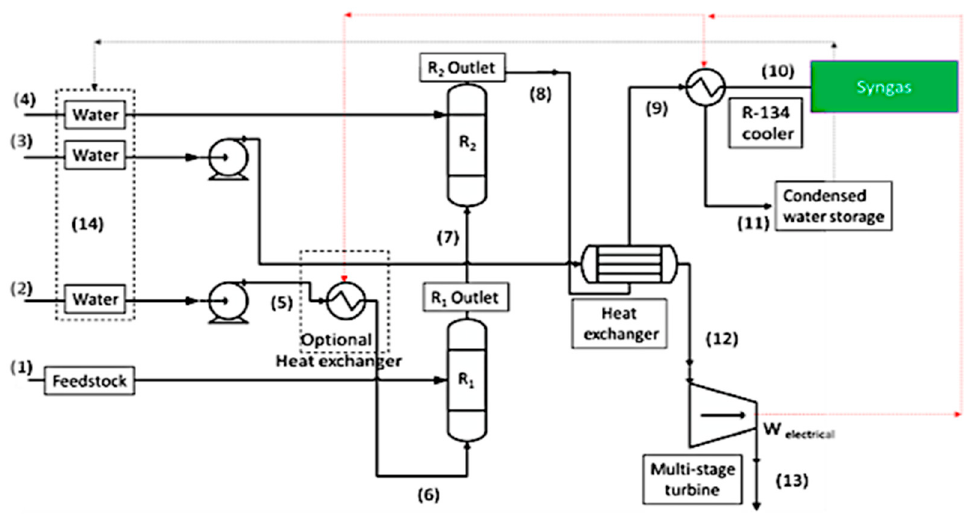
Figure 2. Schematic diagram of the supercritical gasification.